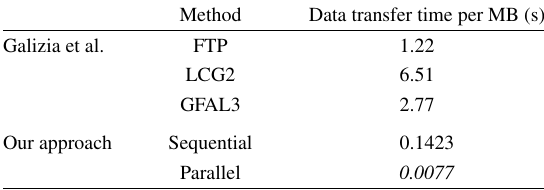
Data transfer speed comparison between this study and Galizia et